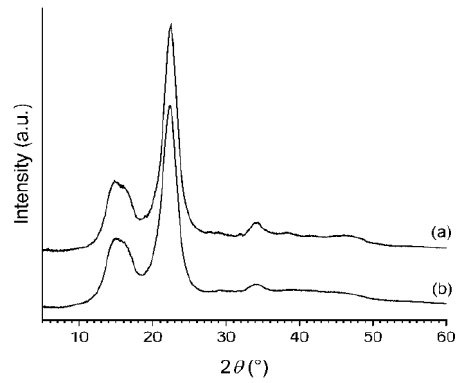
Figure 5. XRD patterns of CNC-EN ( a ), and CNC-CH ( b ).